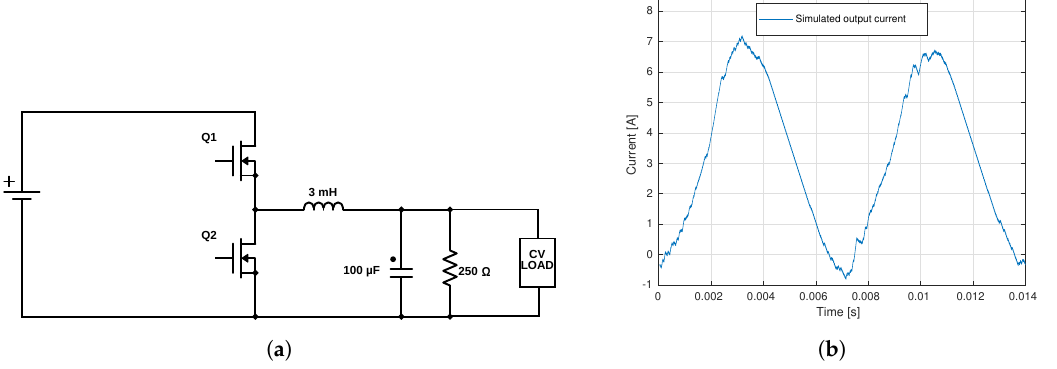
Figure 9. ( a ) Syncronous current output buck converter and ( b ) steady state converter output